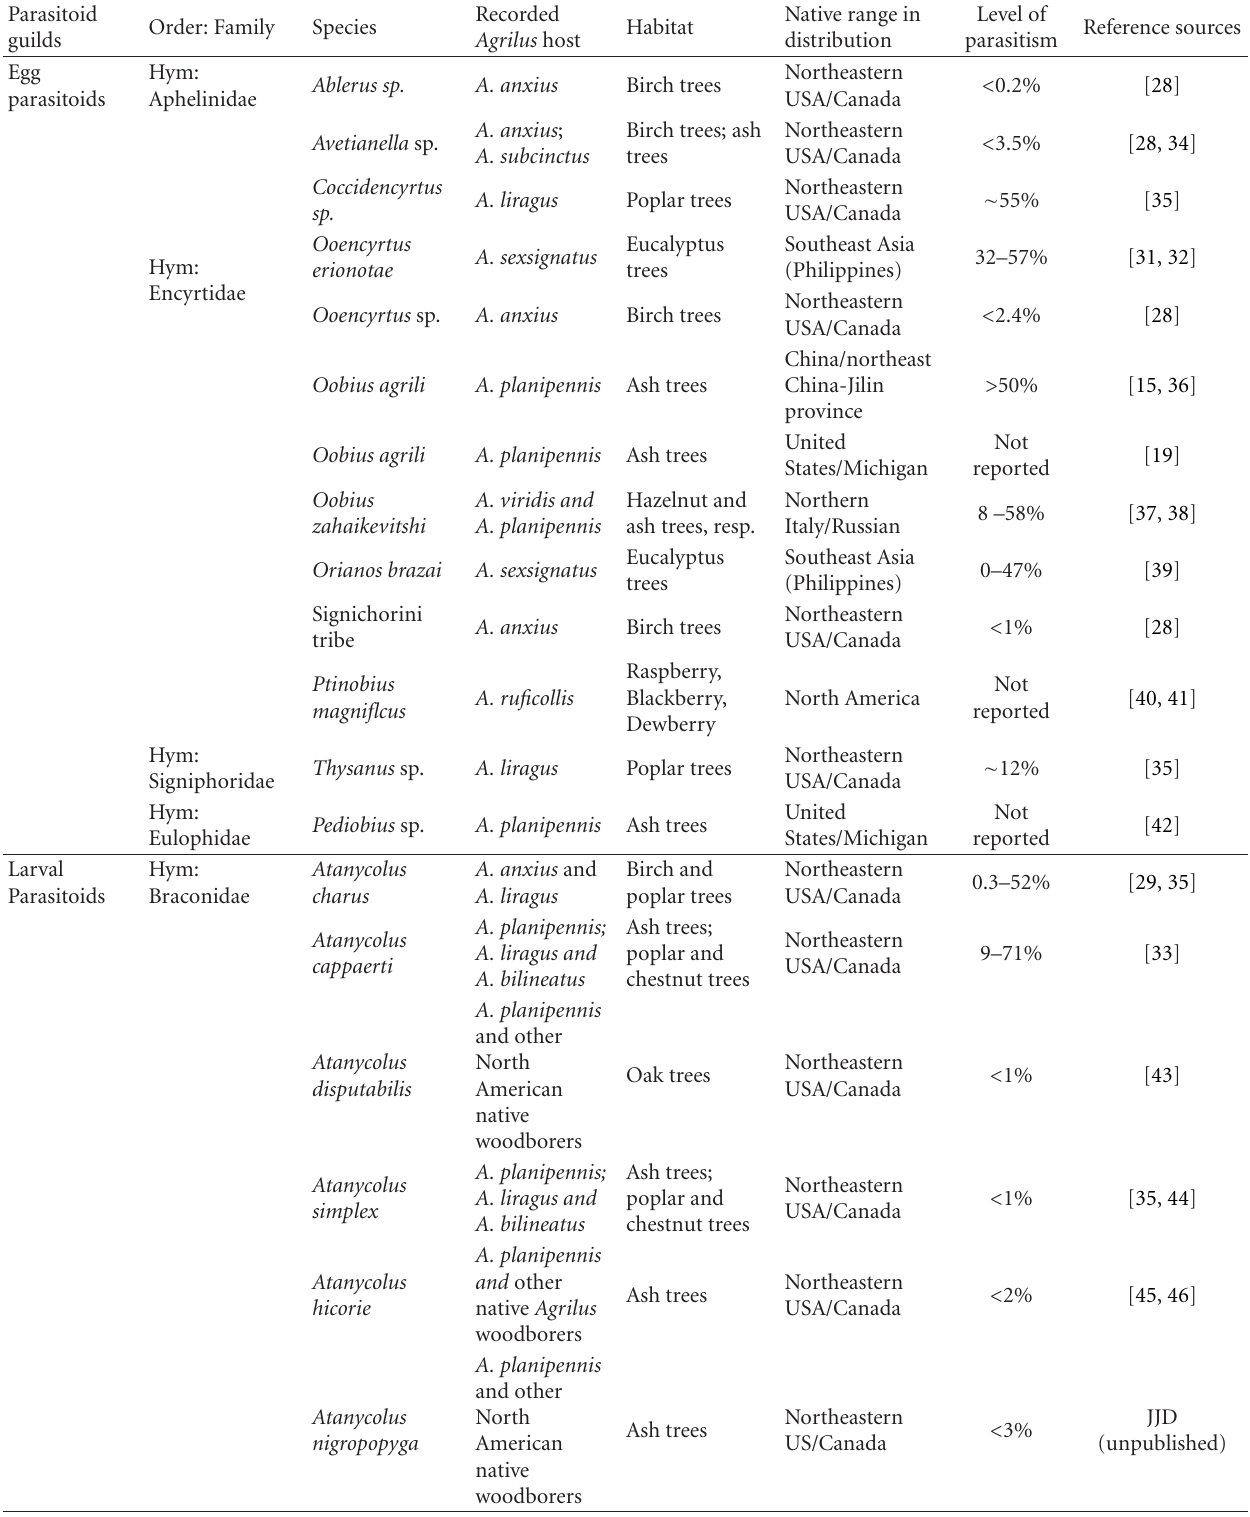
Native range in Level of Reference sources distribution parasitism